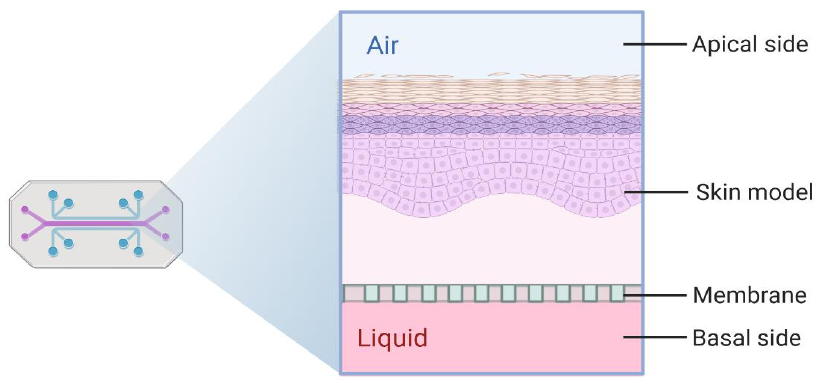
Figure 6. Schematic representation of a polymeric OoC with integrated porous membrane for establishing two separated compartments (apical and basal). A FTSm is generated on top of the membrane and maintained at the ALI with basal perfusion.